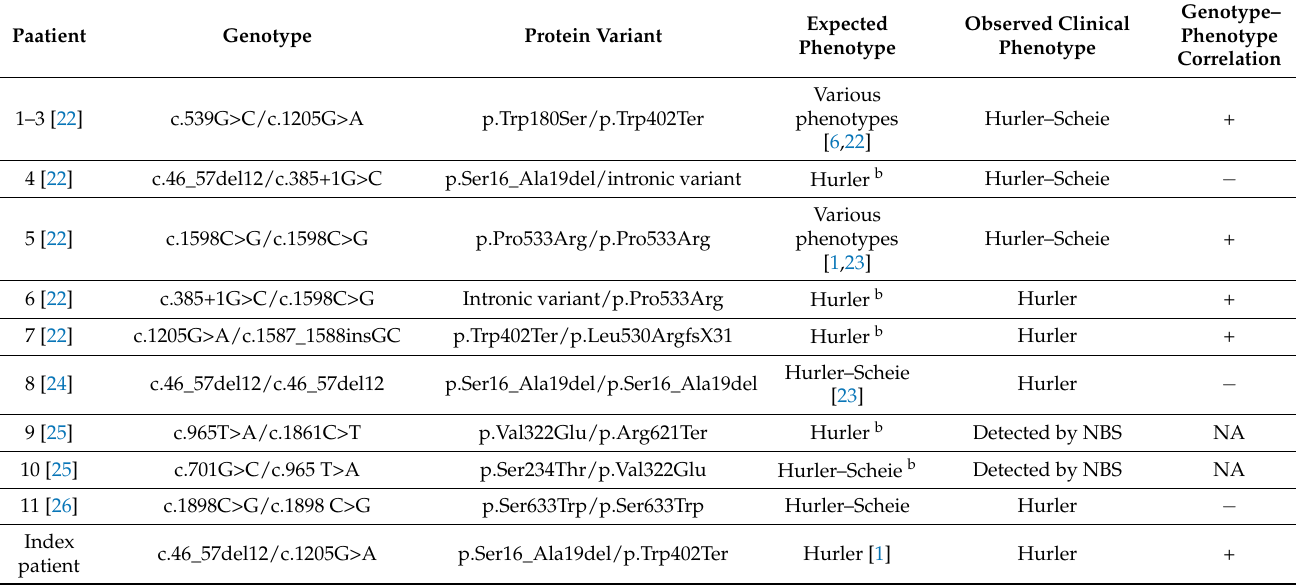
Table 1. IDUA variants and phenotype correlation reported in Mexican